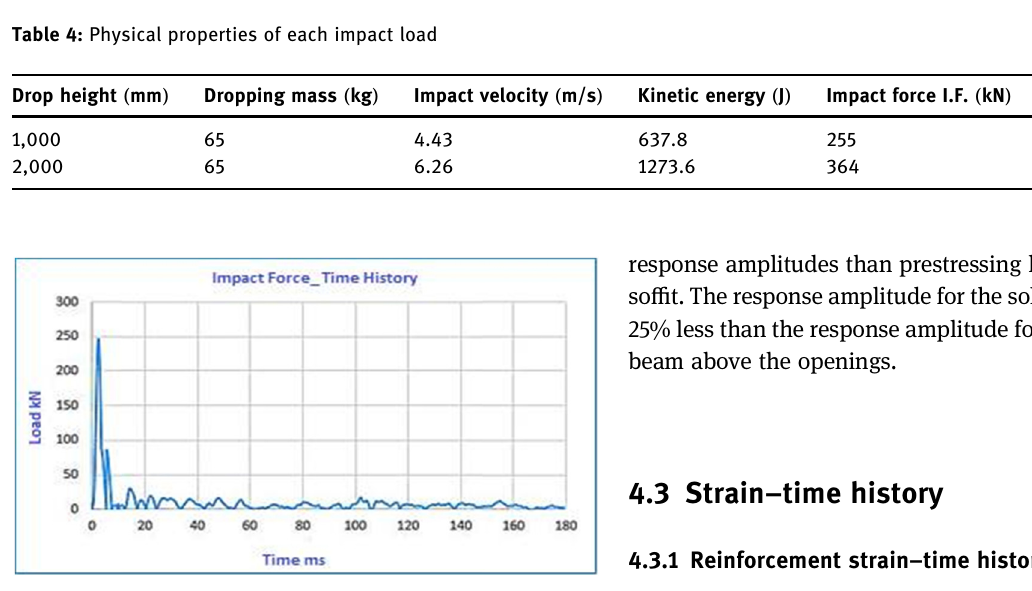
Figure 5: Impact force – time history for 65 kg drop mass with 1,000 mm falling